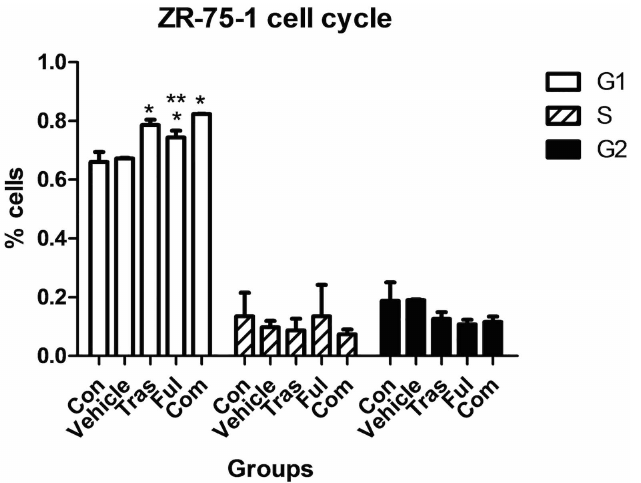
Fig 4. Effects on the cell cycle stage distribution of ZR-75-1 cells after continuous exposure to trastuzumab and fulvestrant as single agents or in combination. Trastuzumab and fulvestrant used as singleagents promoteda statisticallysignificantaccumulationof ZR-75-1 cells in the G1 phaseof the cell cycle when comparedto the control groups. The combination of trastuzumab and fulvestrant caused a statistically significantfurther increasein the percentageof ZR-75-1 cells in the G 1 phase comparedwith the effect of fulvestrant alone ( P = 0.030). * P < 0.05comparedto the control group. ** P < 0.05comparedto the combination group. The cell cycle stage distributionof ZR-75-1 cells in the five different groupsare shown in S3 Fig of the supplementary information